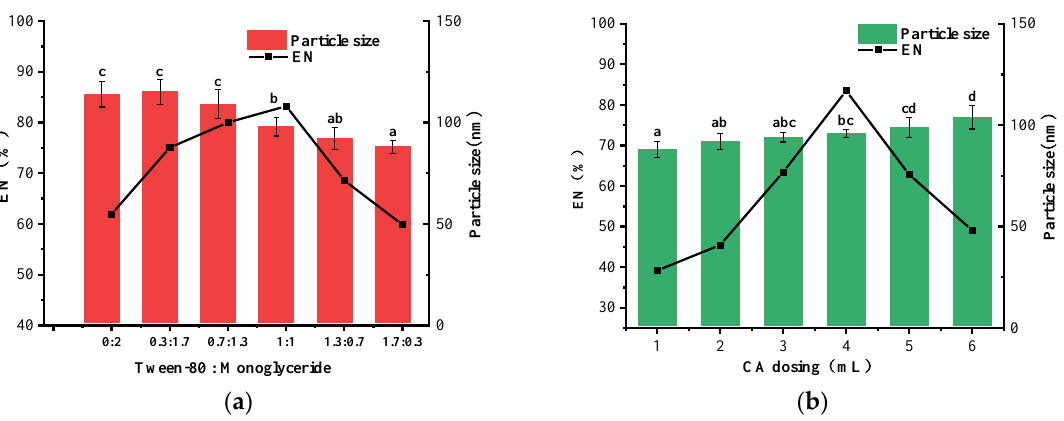
Figure 4. Effect of different ratios of T-80 to MG on the particle size and encapsulation rate of SLN-CA during preparation in a single-factor experiment ( a ); effect of different CA dosing on the particle size and encapsulation rate of SLN-CA during preparation in a single-factor experiment ( b ); error bars indicate the standard deviation of the mean (three replicates); different letters a – c in the figure indicate significant differences in particle size results between treatments based on Duncan’s multiple range test ( p < 0.05).